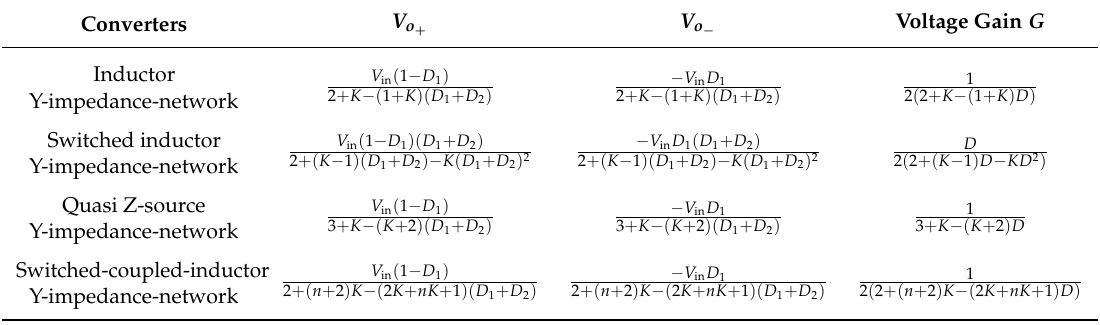
Table 1. Output voltage and voltage gain of the proposed converters with different step-up cell.